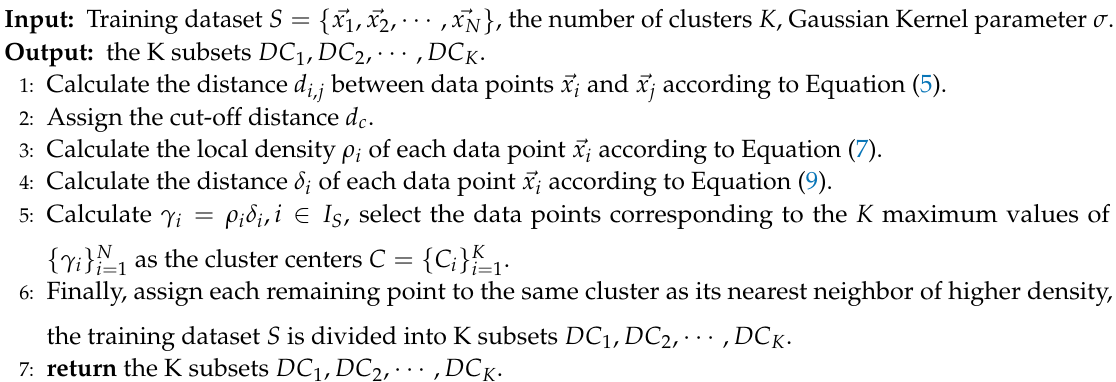
Algorithm 1 MDPCA (Modified Density Peak Clustering